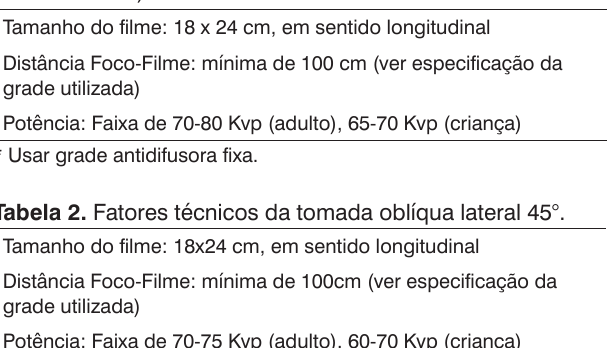
Tabela 1. Fatores técnicos da tomada AP de crânio